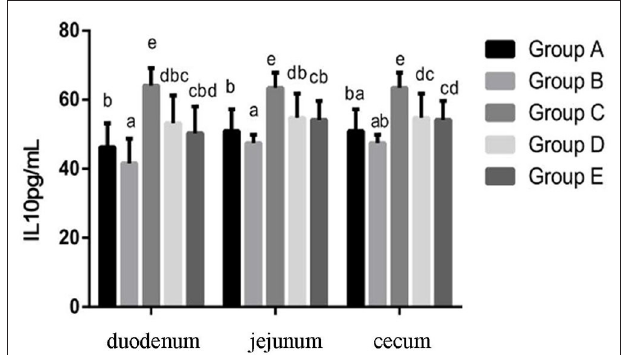
FIGURE 6 | Expression of IL-10 protein in duodenum, jejunum and cecum of different treatment groups. Group A, control group; Group B, infection group; Group C, JYBR-190 pre-fed group; Group D, JYBR-190 fed group; Group E, antibiotic group. Data are expressed as mean ± standard deviation (SD). Different lowercase letters on the columns indicate significant differences ( P < 0.05); the same lowercase letters indicate no significant difference ( P > 0.05).